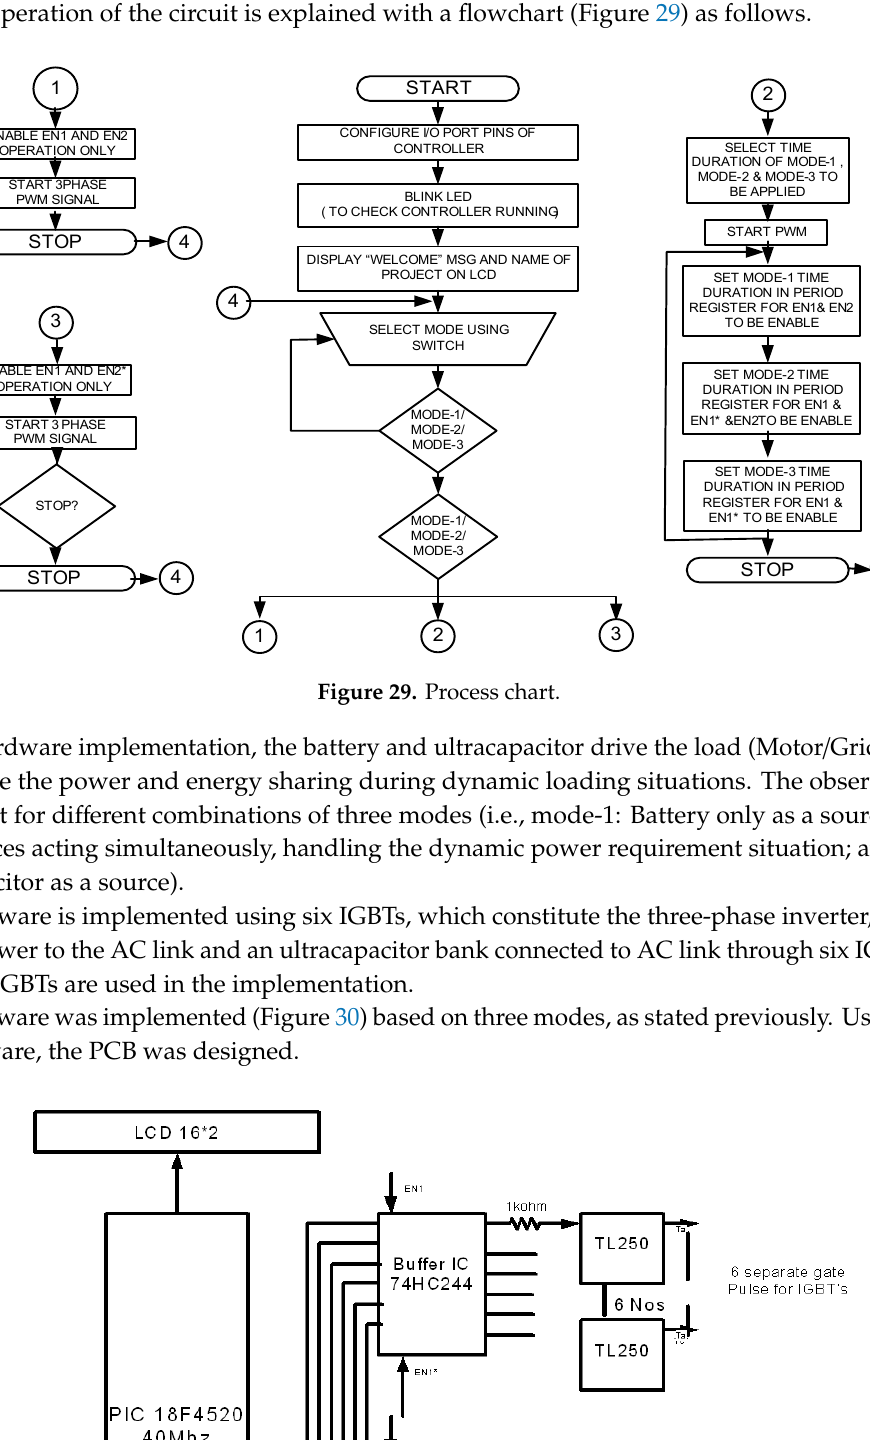
Figure 28. Space Vector Pulse Width Modulation (SVPWM) control signal generation in protease. The operation of the circuit is explained with a flowchart (Figure 29) as follows.